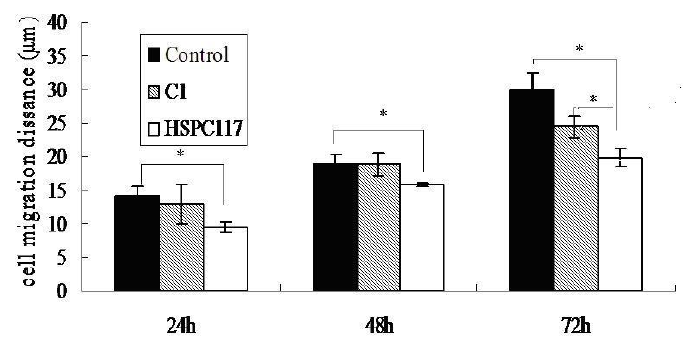
Figure 4. Cell migration distances of JEG-3 cells transfected with C1 or C1/HSPC117 plasmids at 24, 48, and 72 h (* p < 0.05, compared to non-transfected